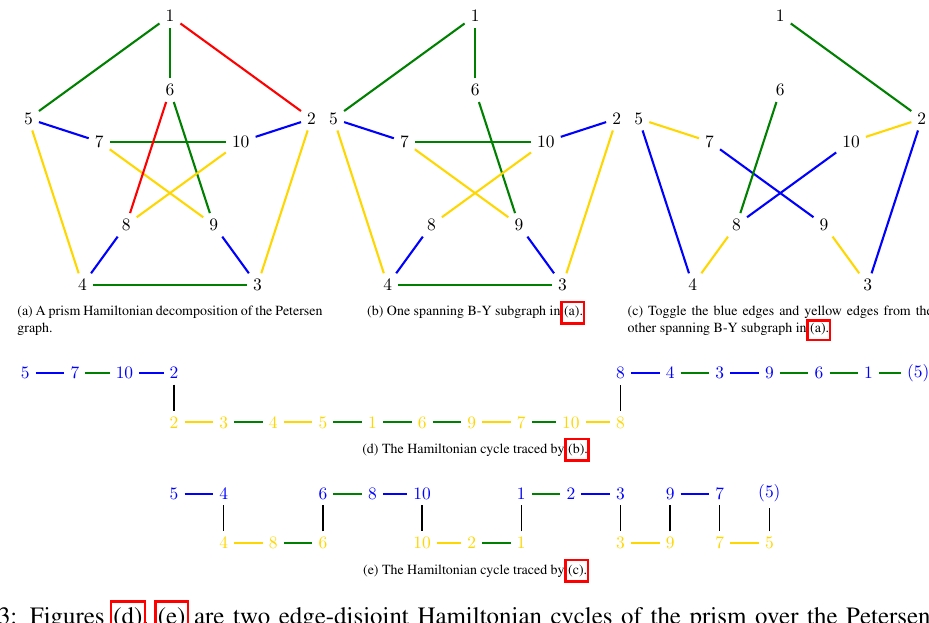
Fig. 3: Figures (d), (e) are two edge-disjoint Hamiltonian cycles of the prism over the Petersen graph traced by the two spanning B-Y subgraphs shown in (a). The color usage is described in Remark